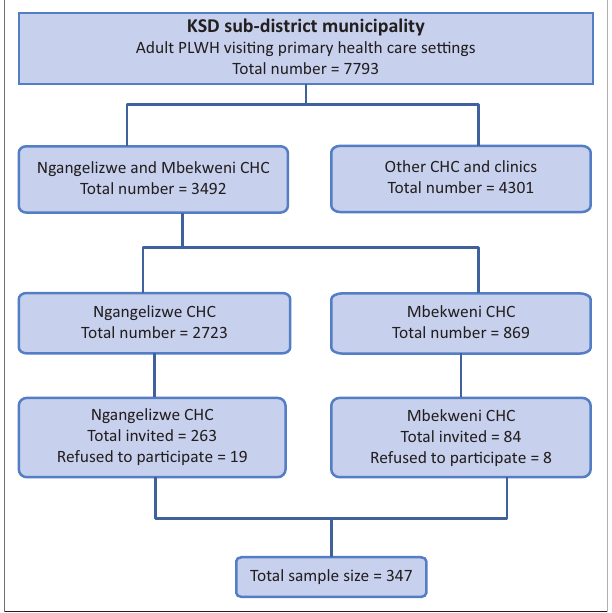
FIGURE 1: Sampling frame for people living with human immunodeficiency virus in King Sabata Dalindyebo sub-district municipality who visited primary healthcare settings between 15 March and 15 April 2018.